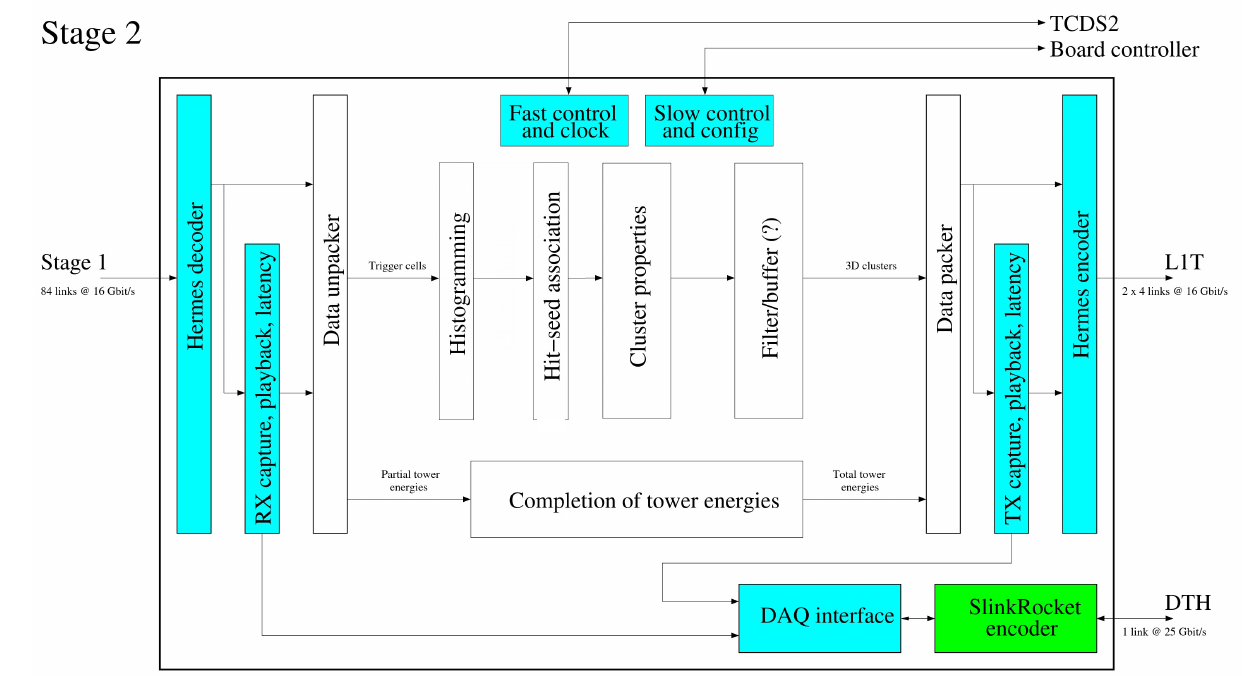
Figure 6. Schematic view of the current HGCAL TPG Stage 2 algorithmic